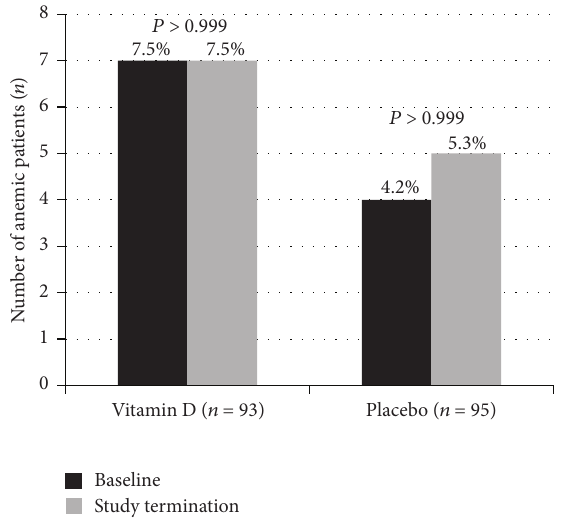
Figure 1: Anemia proportion in participants of the Styrian Vitamin D Hypertension Trial at baseline and study termination (by study group). 𝑃 values indicated within study group